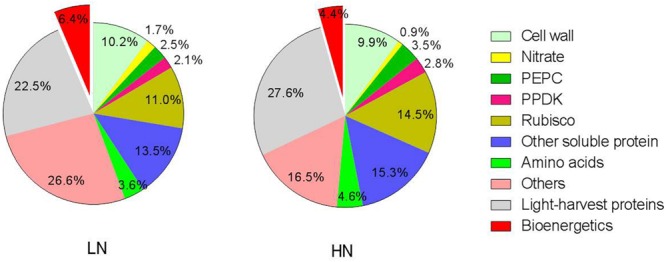
Effect of nitrogen (N) supply on the percentage of different N components in total ear-leaf N. Exploded slices were significantly different between high and low N supply at P < 0.05.